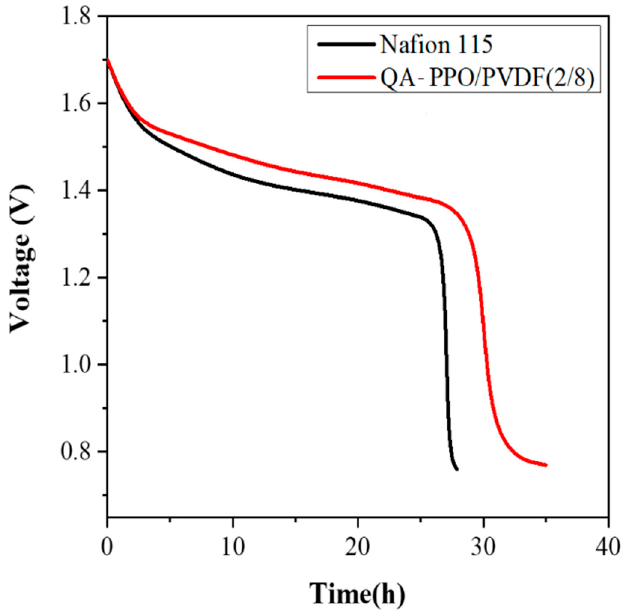
Figure 7. Open circuit voltage of vanadium redox flow battery assembled with Nafion 115 and QA–PPO/PVDF(2 / 8).